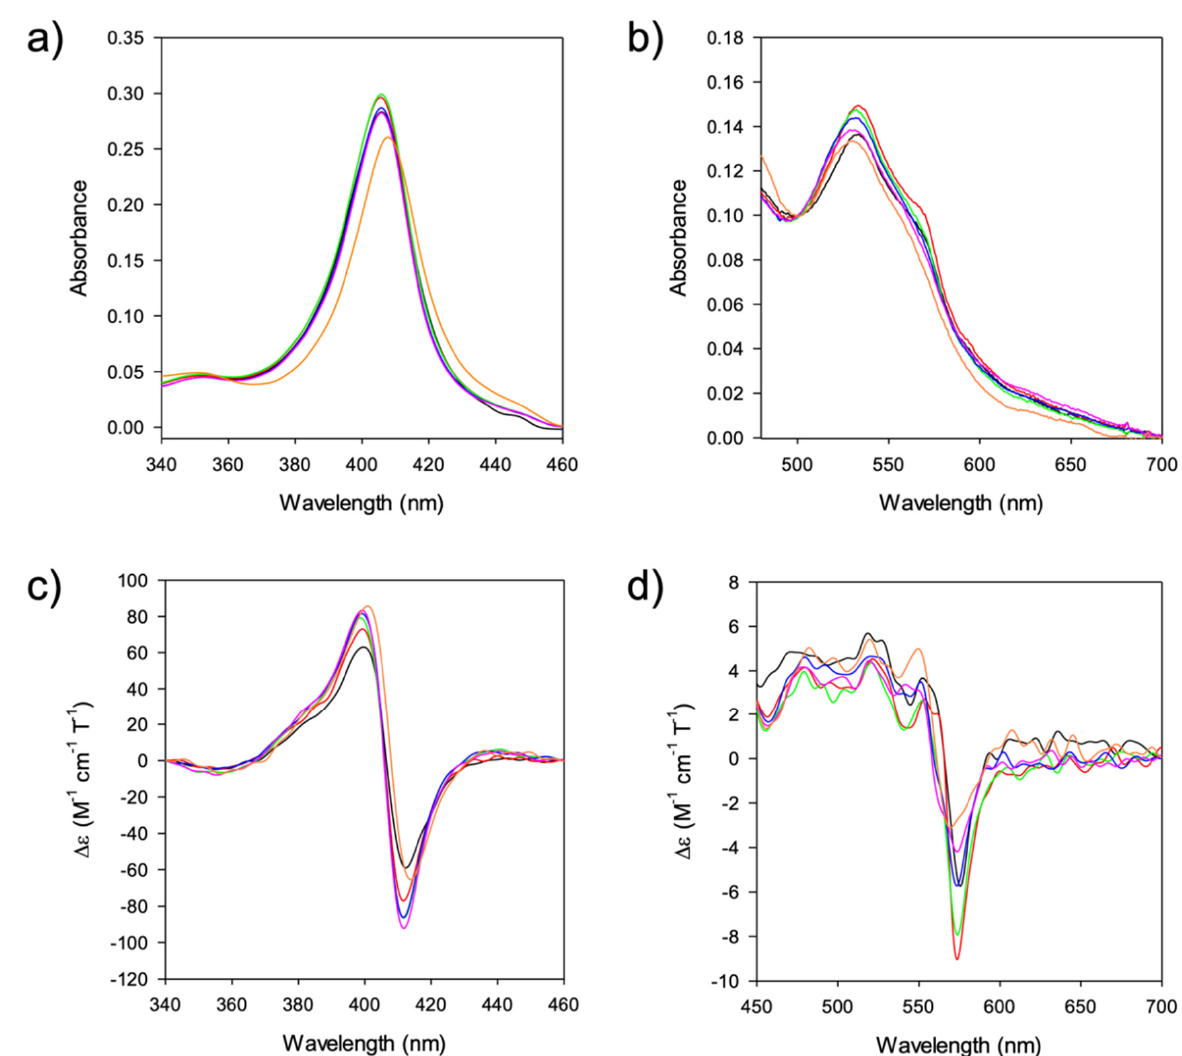
Figure 8. Spectra of M80A cytc at increasing DMSO concentration in 10 mM phosphate buffer, pH 7.0. ( a ) Electronic absorption in the Soret region; ( b ) Electronic absorption in the visible region; ( c ) MCD in the Soret region; ( d ) MCD in the visible region. Black: 0% DMSO; Red: 10% DMSO; Green: 20% DMSO; Blue: 30% DMSO; Pink: 40% DMSO; Orange: 50% DMSO.